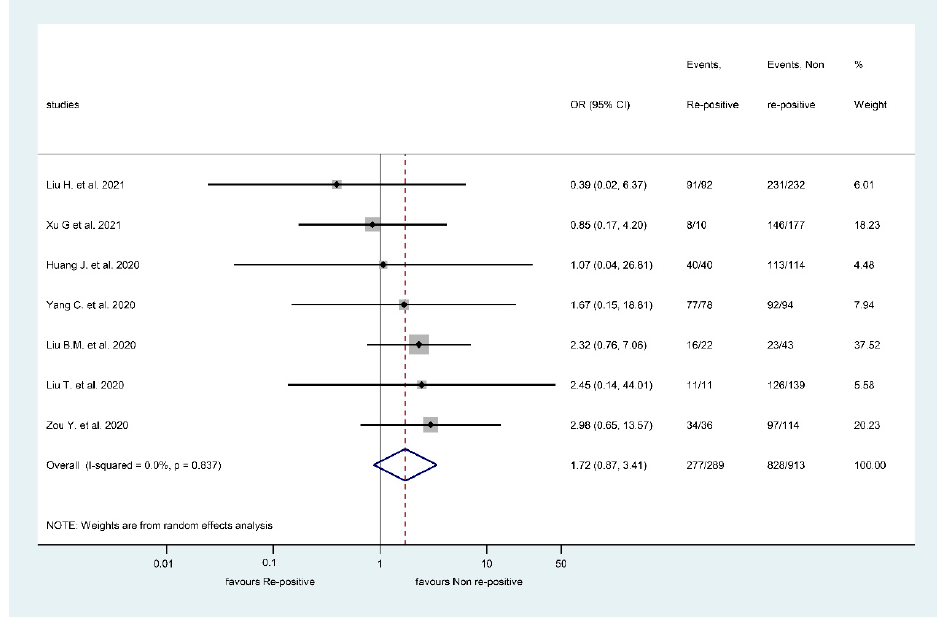
Figure 3. Forest plot representing that repeatedly SARS-CoV-2 positive episode is not associated with Immunoglobulin G positivity.